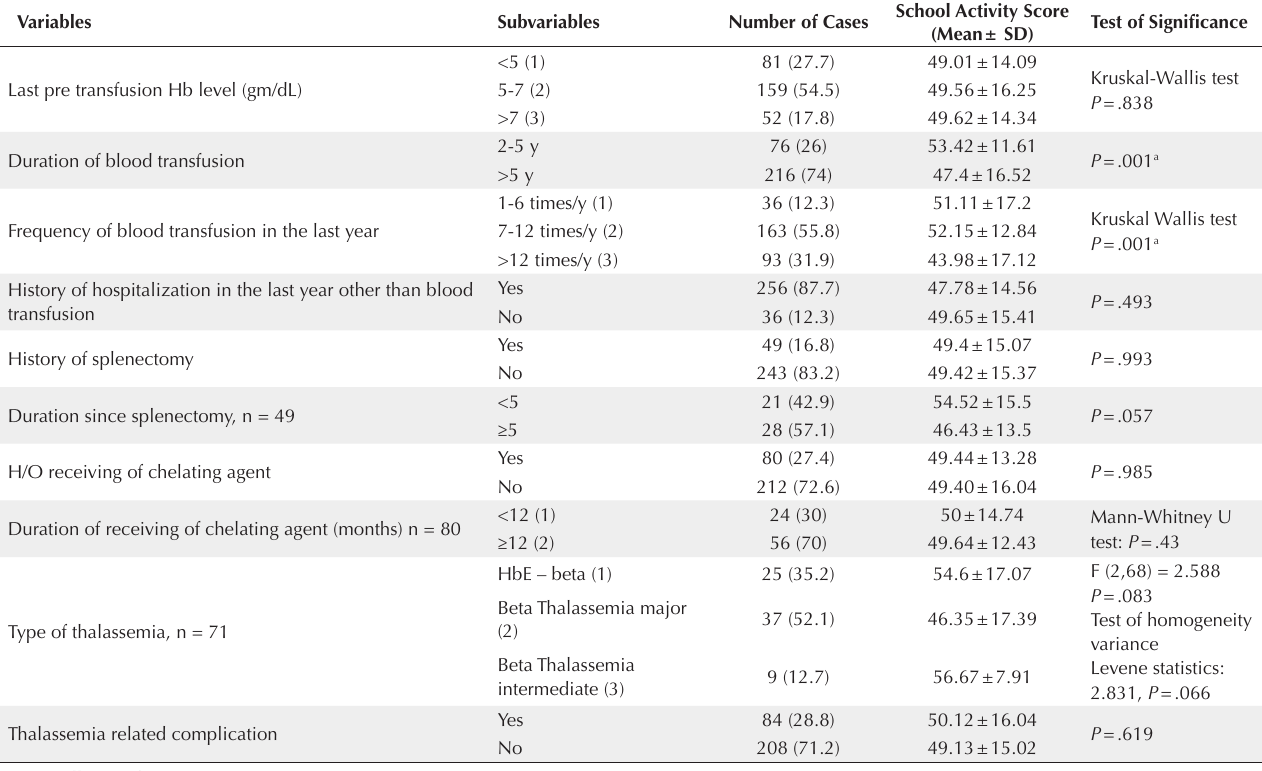
Table 3. Distribution of School activity score according to clinico-therapeutic profiles of the patients